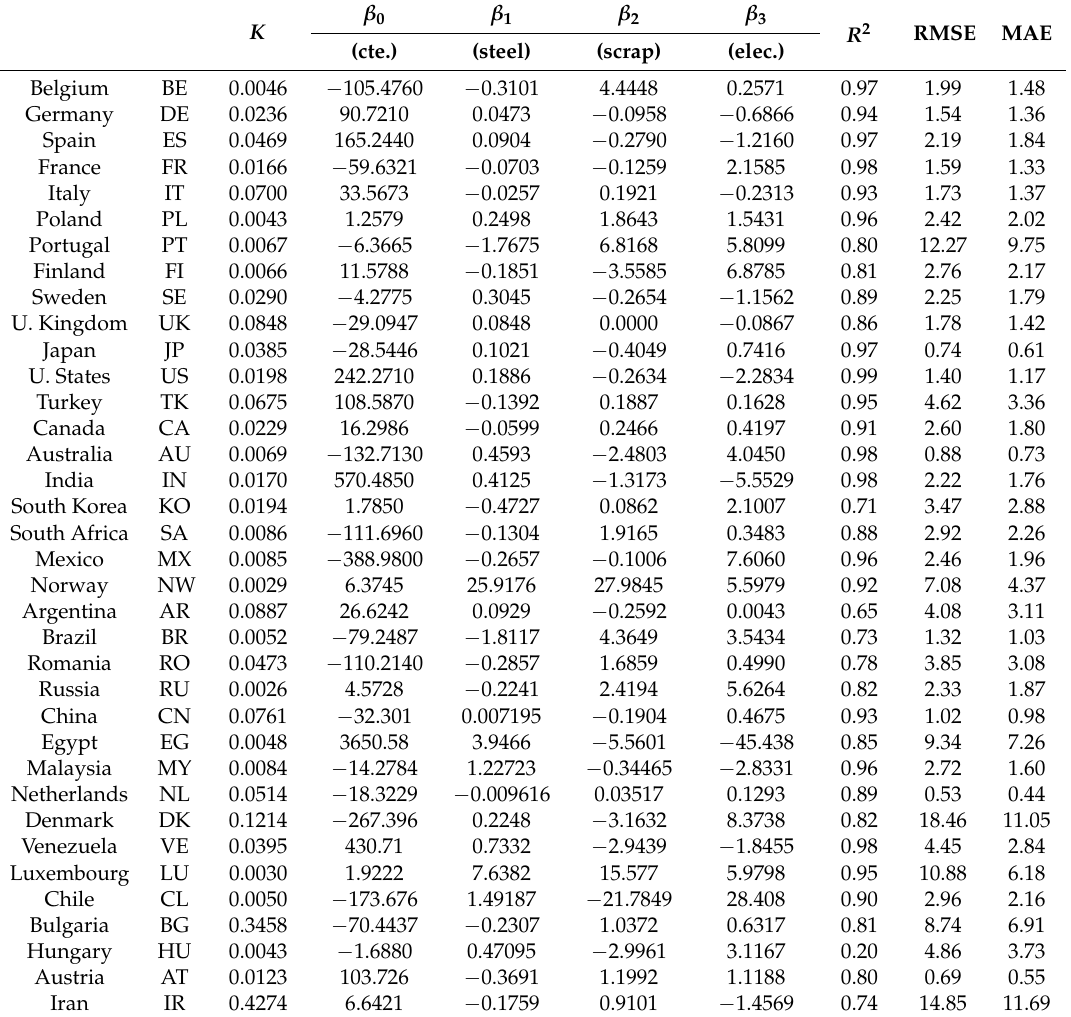
Table 2. Values of K and the parameters β 0 , β 1 , β 2 , β 3 that produce the best fit between the percentage of EAF observed and